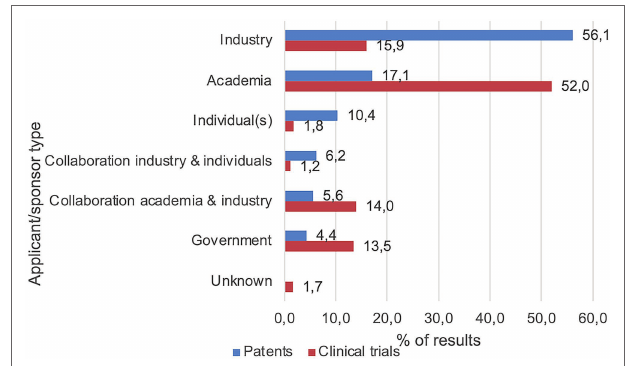
FIGURE 5 | Main applicant/sponsor types included industry and academia. Values represent percentages of the number of included patents and clinical trials,